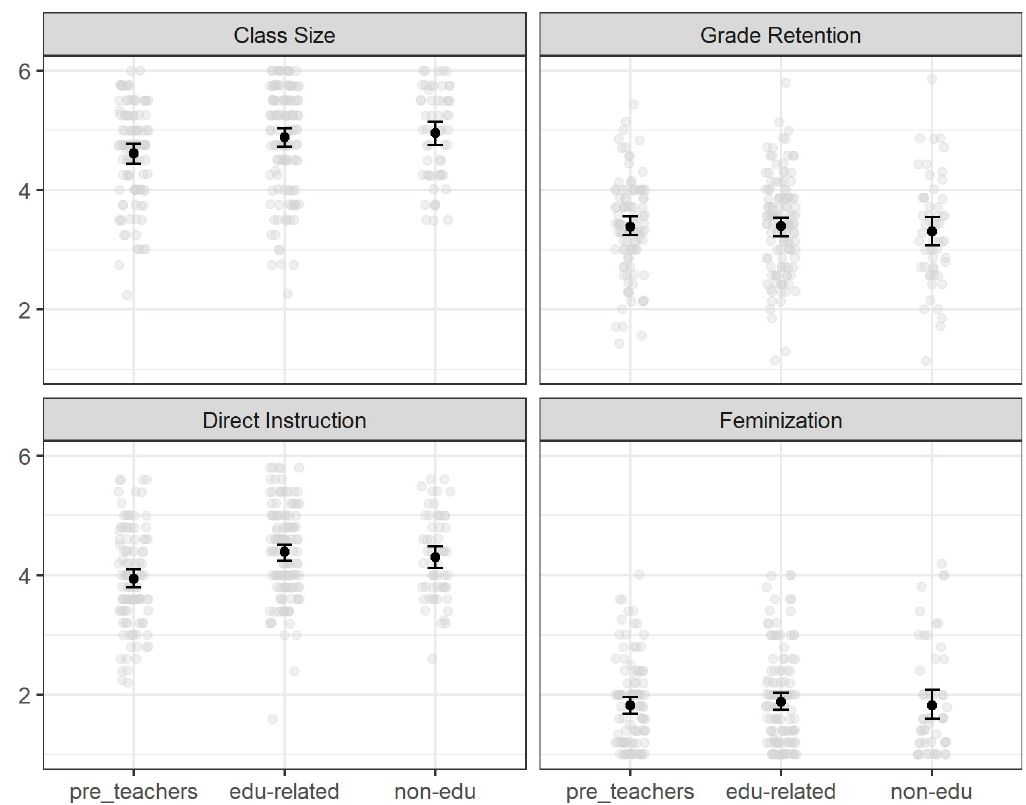
Fig 1. Educational misconceptions by field of study. The figure shows the means and 95% confidence intervals of the agreement to the educational misconceptions across the three student groups in this study. Higher values indicate higher